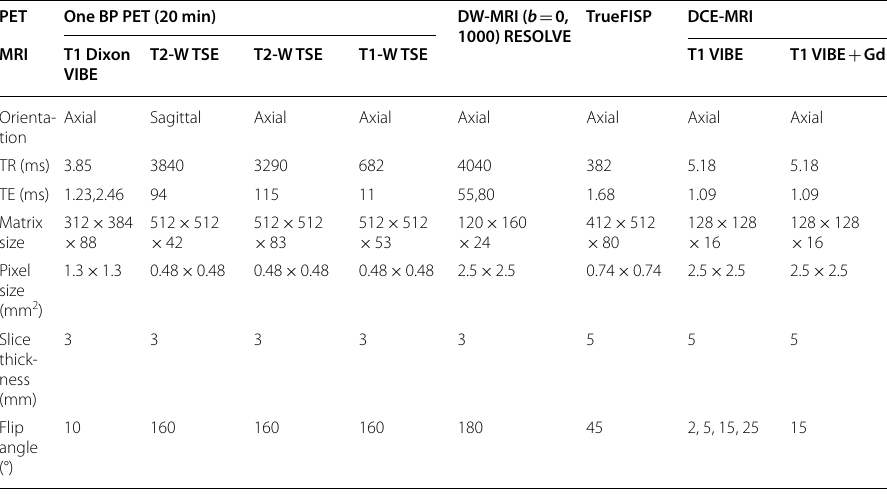
VIBE volumetric interpolated breath‑hold, TSE turbo spin‑echo, BP Bed